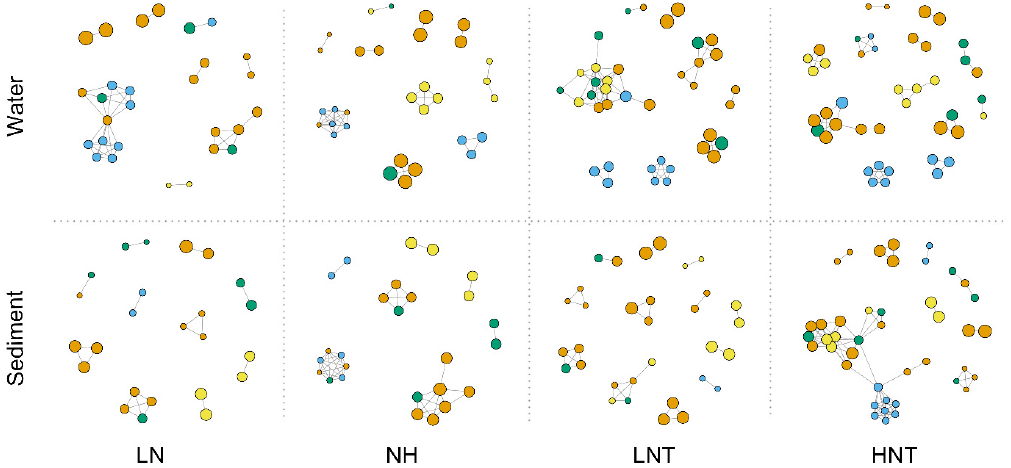
Figure 2. Network analysis between C and N functional genes in water and sediment samples. Each node represents a functional gene. Nodes were colored based on the functional gene (b) (R 2 > 0.8 and p < 0.01). Blue for C functional genes and yellow for N functional genes. Node sizes weighted based on the node degree (the number of connections between a node and other nodes). Edges were colored based on the nodes they connected. Blue for C and yellow for N.